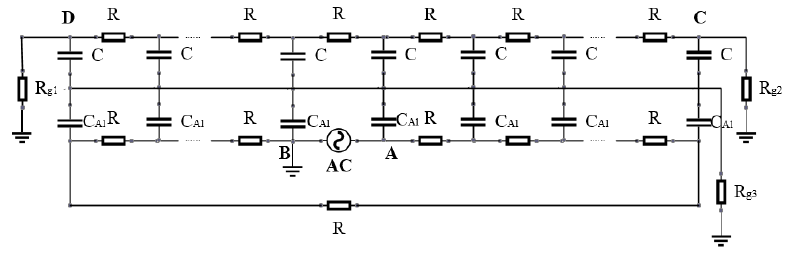
7 of 12 Figure 6. Simplified simulation model of inductosyn. Figure 7. Influence of stator substrate on capacitive potential. From the above analysis, it can be seen that the aluminum substrate structure needs to be adopted in the stator of inductosyn, and the insulation layer should be as thin as possible to effectively suppress the capacitive potential. This also verifies that the angle measurement accuracy of inductosyn made by traditional PCB process is very low. The organic substrate is too thick, so the capacitive potential is difficult to fully suppress. In order to solve these problems, we should use aluminum-based PCB processes or flexible PCB processes to produce inductosyn. 4.2. Aluminum Shielding Film Aluminum shielding film, which covers the inductosyn conductor, is another